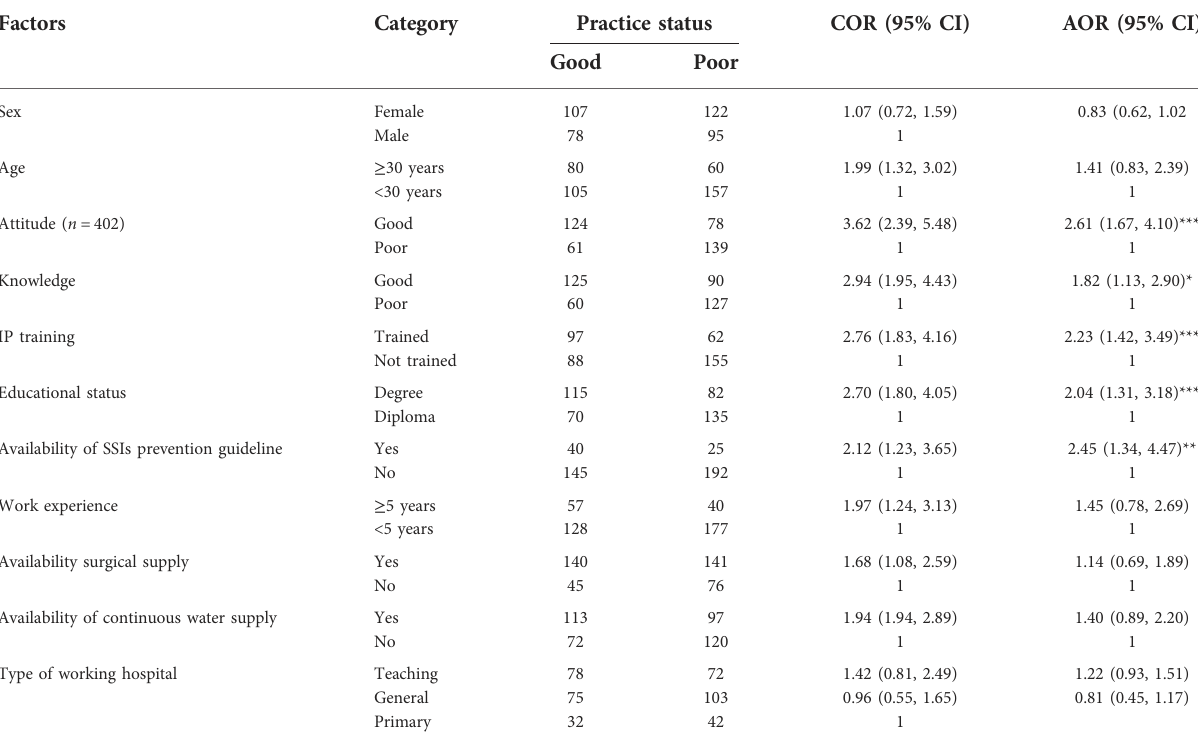
TABLE 5 Bivariable and multivariable logistic regression analysis showing the association between factors and surgical site infection prevention practice among nurses working at public hospitals in the western part of SNNPR, Ethiopia 2020, ( n =402). Factors